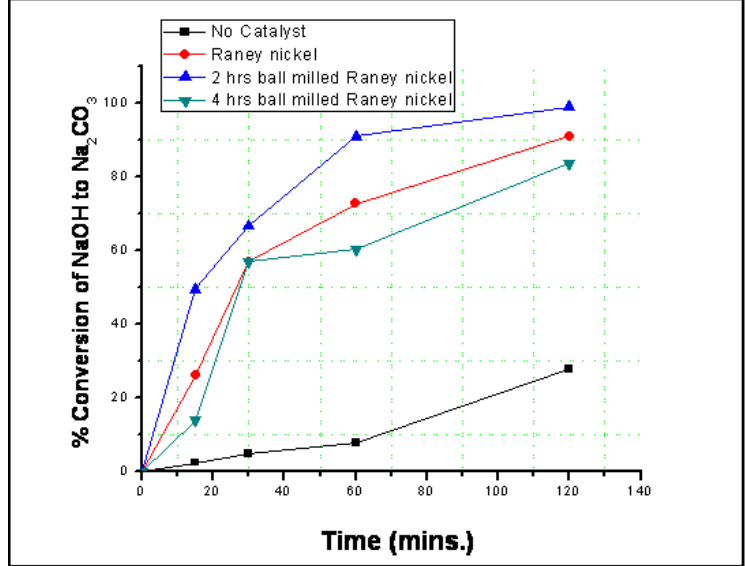
Figure 7. % Conversion of NaOH to Na time has exhibited the best